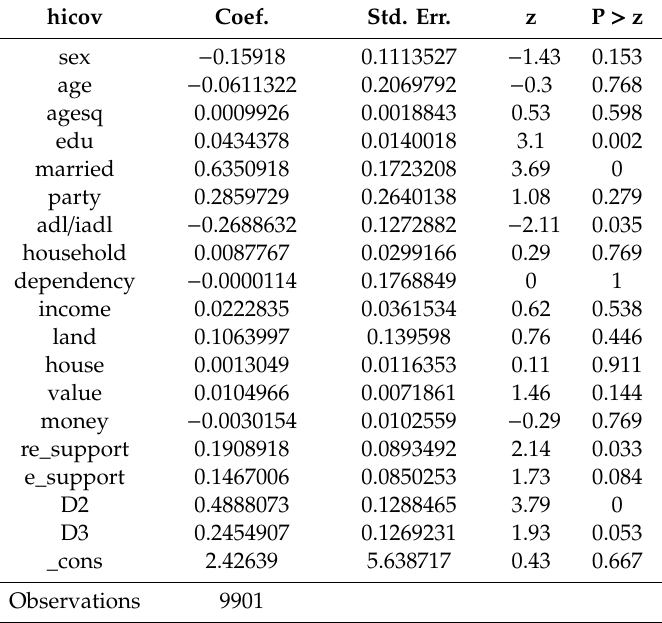
Table 8. Estimation of Logit for farmers’ participation in health insurance decision making. hicov Coef.